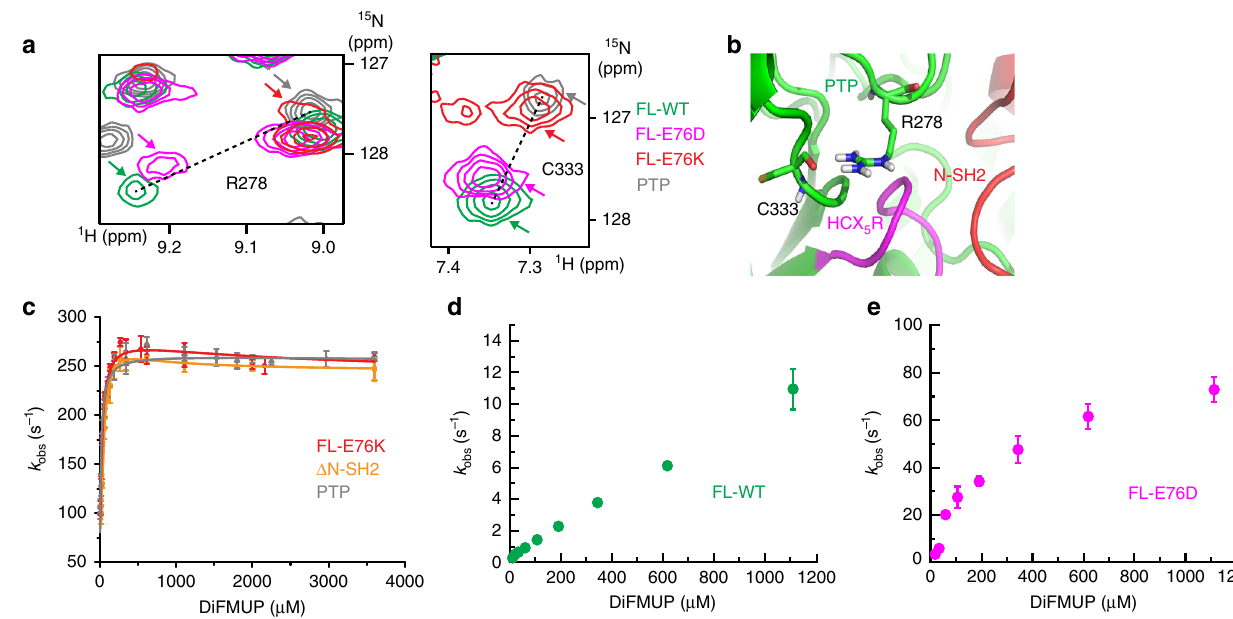
Fig. 3 Open/closed equilibrium of WT and SHP2 mutants correlates with enzymatic activity. a Selected region of the [ 1 H- 15 N]-TROSY-HSQC spectra (residues R278 and C333 in the PTP domain) shows linear shifting of cross peaks from PTP via FL-E76K and FL-E76D to FL-WT. b R278 and C333 are shown in stick representation, showing their spatial proximity to the active site of the catalytic domain (the HCX 5 R motif) and the N-SH2 domain. c – e Phosphatase activity as a function of substrate (DiFMUP) concentration measured at 35 °C. c The pro fi les for PTP, Δ N-SH2, and FL-E76K are within experimental error and were fi t to the Michaelis – Menten model with partial substrate inhibition (Eq. 1, fi t parameters in Supplementary Fig. 7b). d , e FL-WT and FL-E76D show much less activity combined with a weaker apparent K M . Uncertainties represent the standard deviation of the sample ( n =